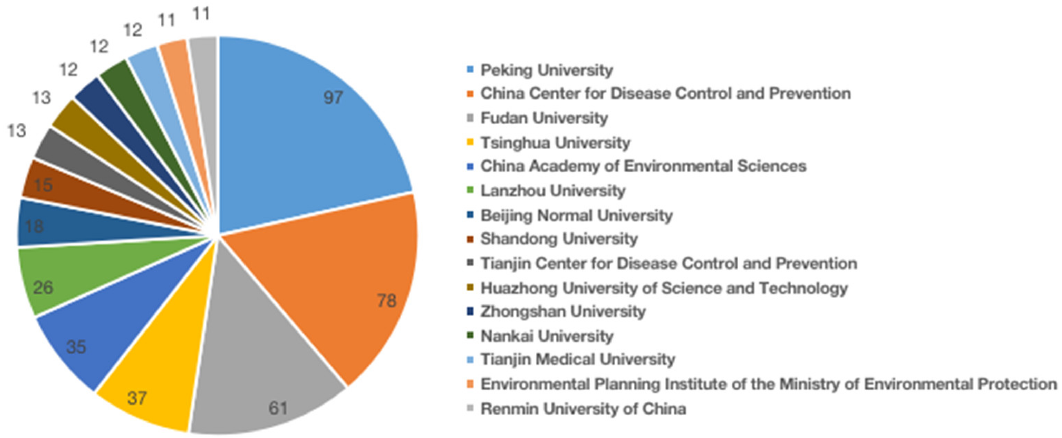
Figure 5. Chinese publication institutions of air pollution and health research.